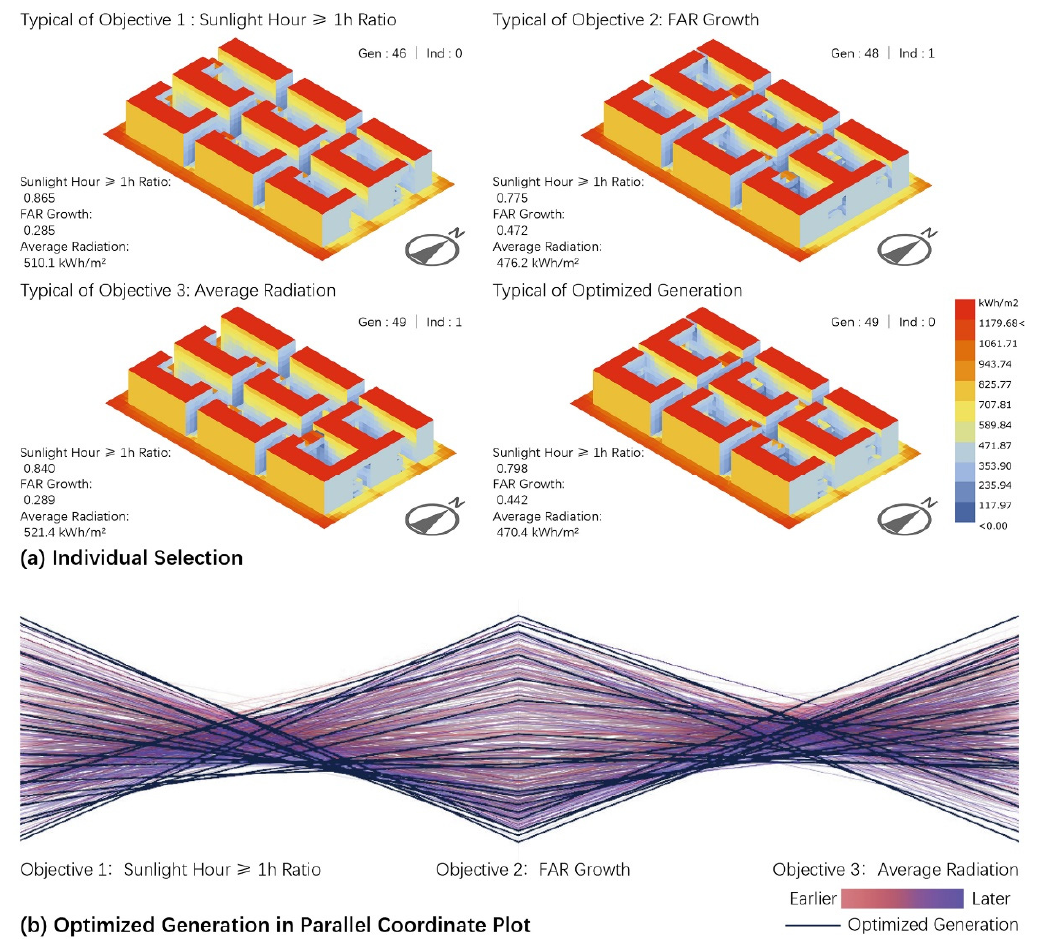
Figure 7. Selected solutions of the horizontal addition mode.